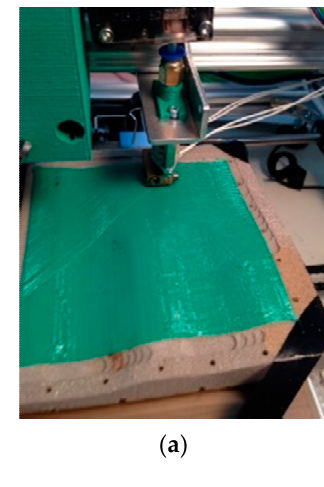
Figure 10. External coating manufacturing: ( a ) different orientations of the 3D paths are visible; ( b ) the final laminate is extracted from the mould.